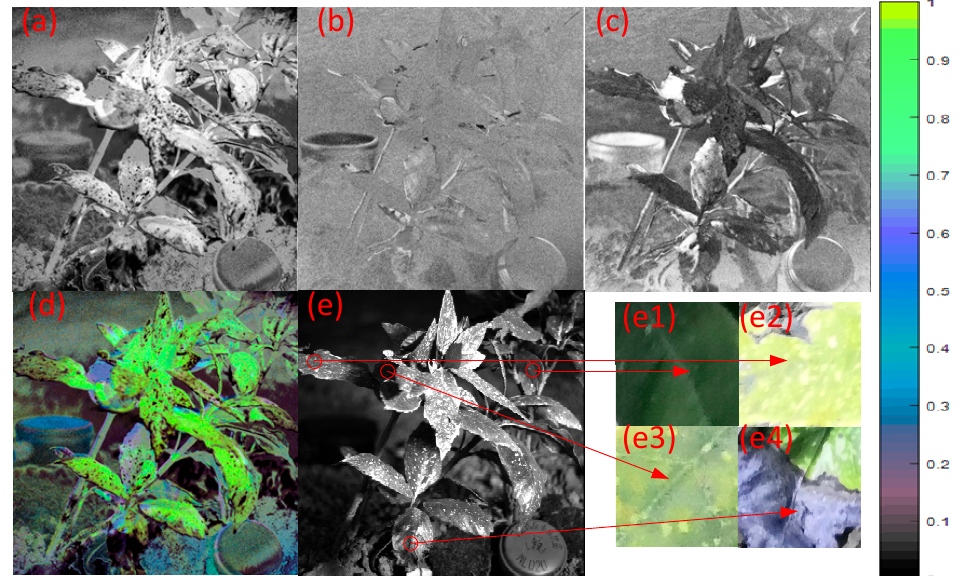
Figure 12. ( a ) NDVI image, ( b ) AOP image, ( c ) DoLP image, ( d ) fusion image (NDAI), ( e ) gray-scale image, ( e1 ) healthy leaf region, ( e2 ) level-2 stress leaf region, ( e3 ) level-1 stress leaf region and ( e4 ) withered leaf region.